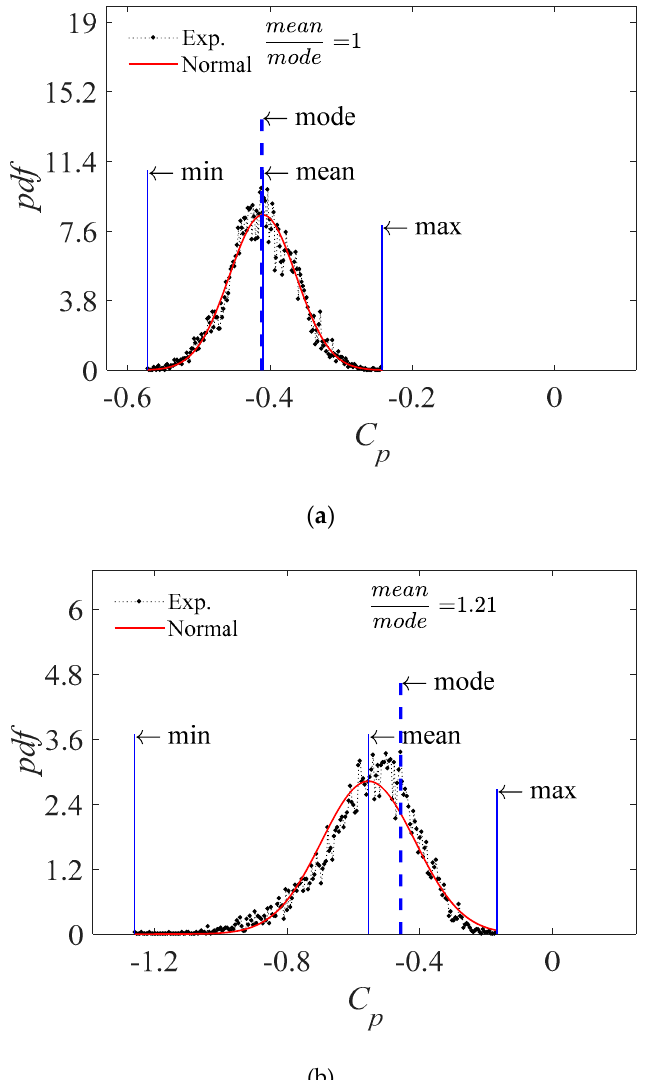
Figure 4. Gaussian process, model 1, #19 = 0° pdf (probability density function) ( a ); non-Gaussian process #2 = 0° ( b ).